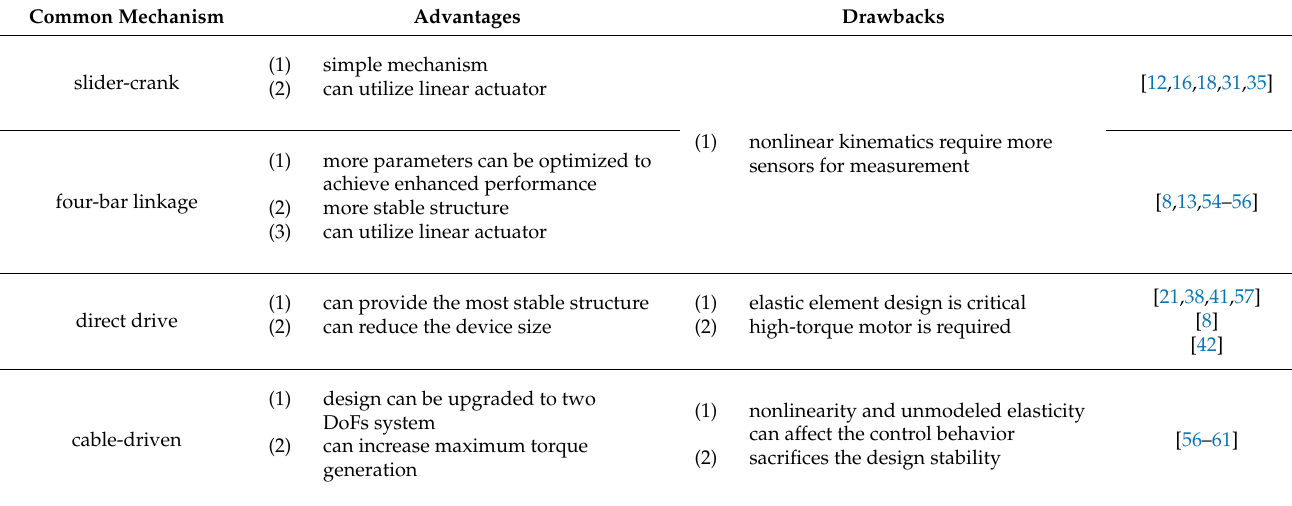
Table 3. Mechanisms commonly used in powered